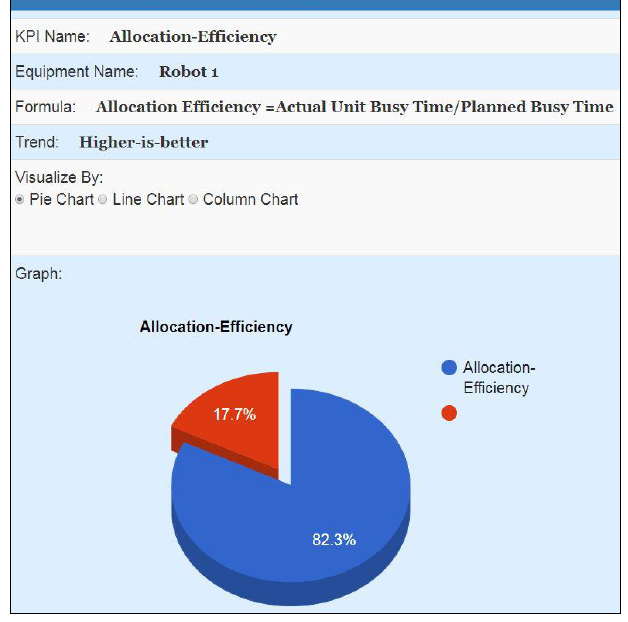
Figure 12. Allocation Efficiency KPI of Robot 1.